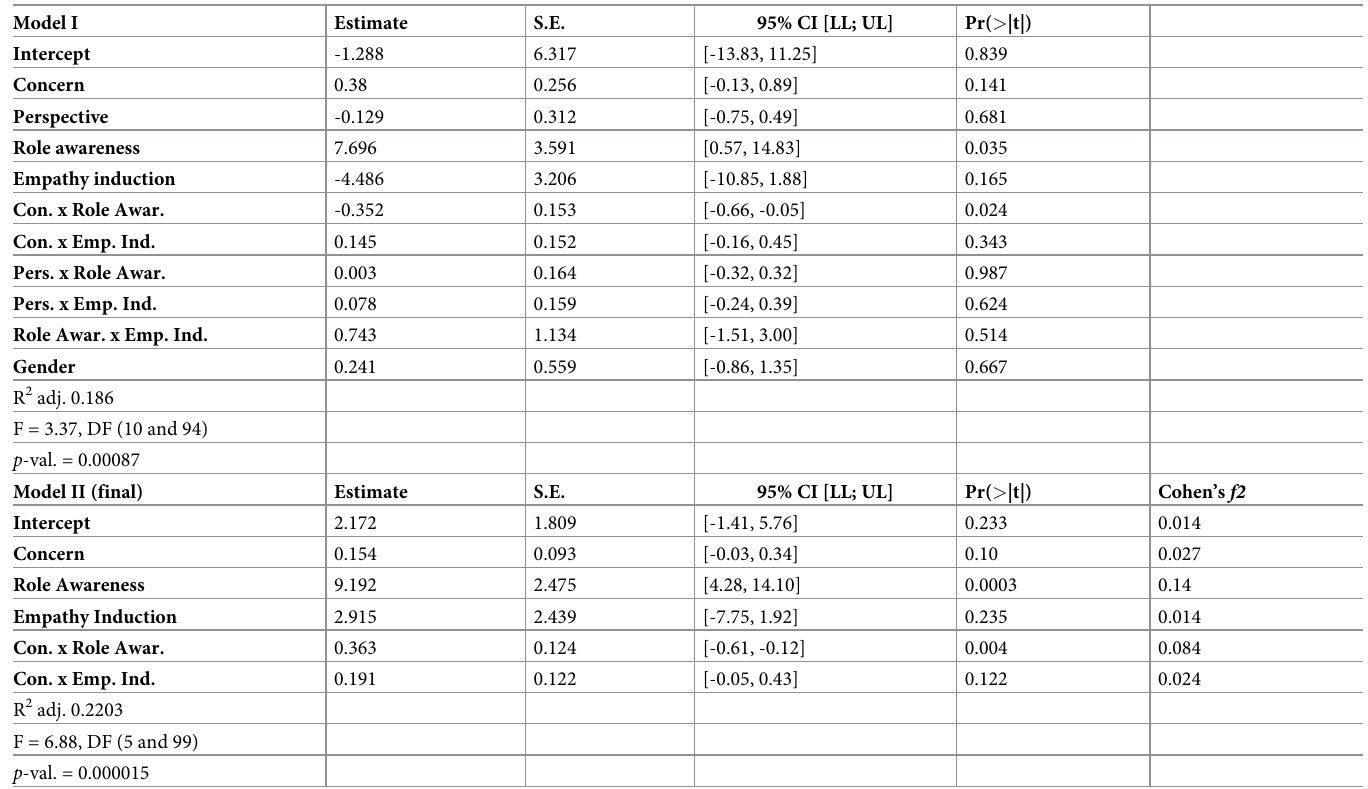
Table 5. Regression results of dictator game giving, IRI’s subscales as predictors. Model